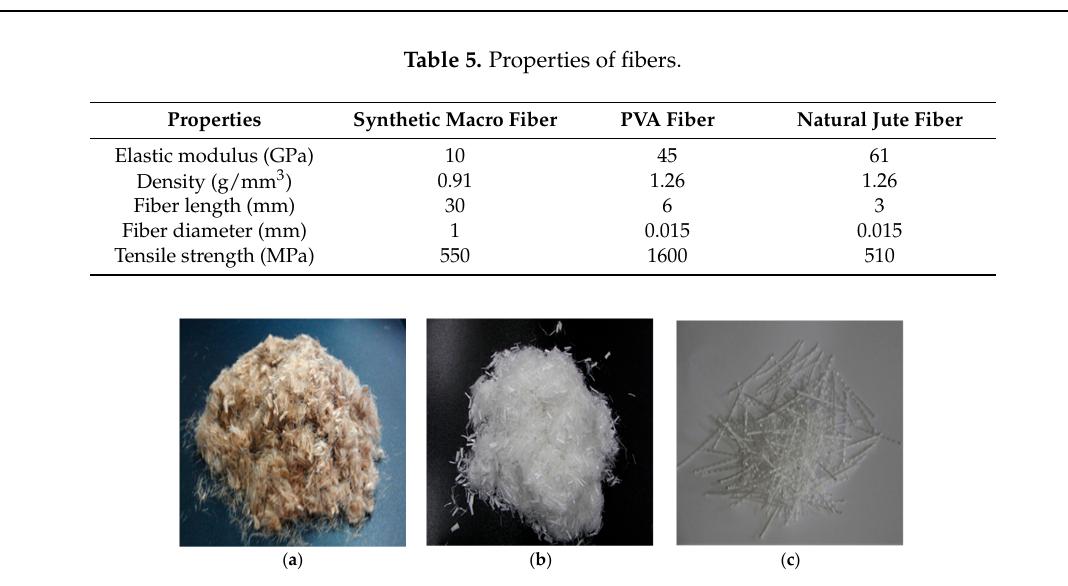
Table 4. Properties of styrene butadiene latex.